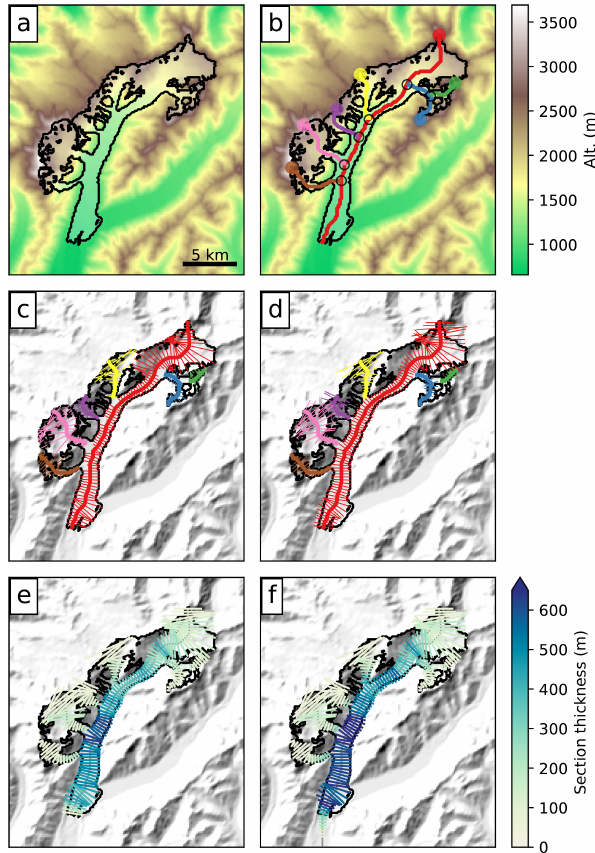
Figure 1. Example of the OGGM workflow applied to Tas- man Glacier, New Zealand: (a) topographical data preprocessing; (b) computation of the flow lines; (c) geometrical glacier width de- termination (the colors indicate the different flow lines); (d) width correction according to catchment areas and altitude–area distribu- tion (see Fig. 2 and main text for details); (e) ice thickness inver- sion; and (f) random 100-year-long glacier evolution run leading to a glacier advance. See Sect. 2.1 for